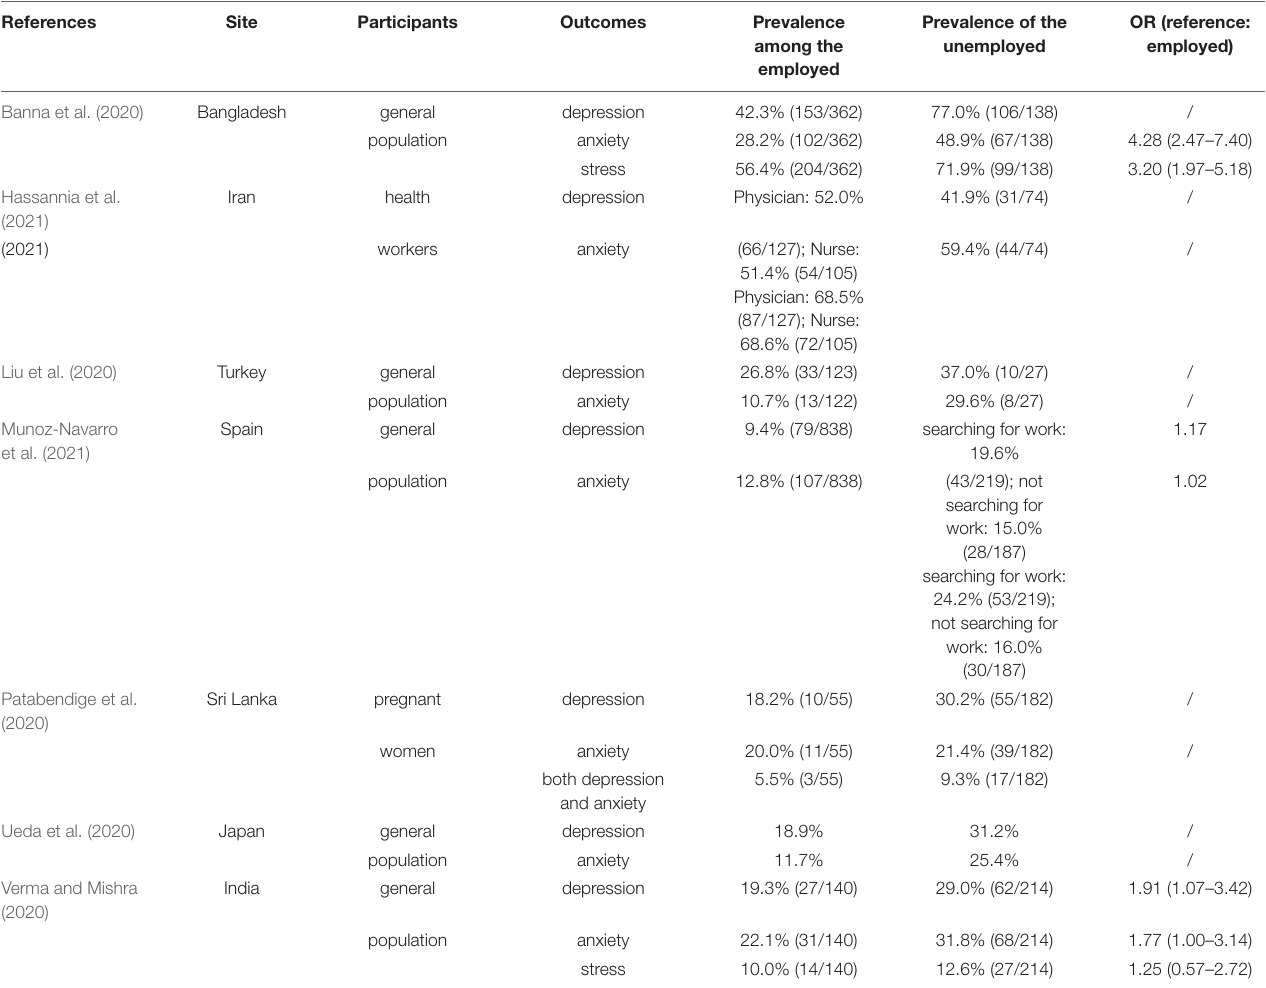
TABLE 2 | Summary of findings comparing prevalence of mental health problems between the employed and the